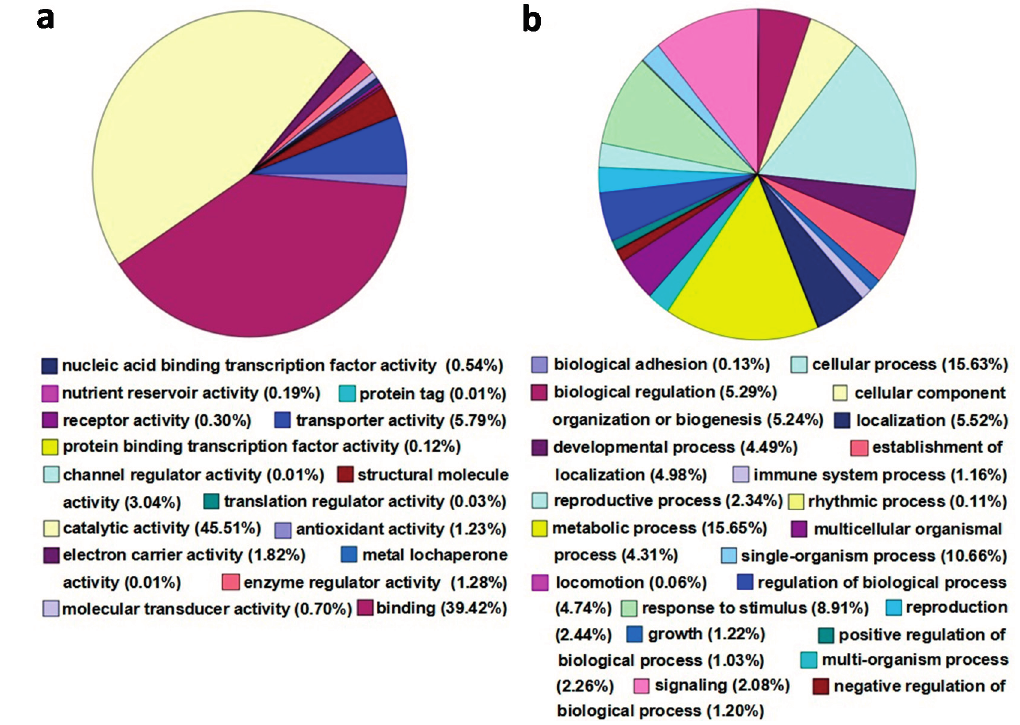
Figure 3. Gene Ontology (GO) annotation of the whole identified proteins. ( a , b ) represented the classification of molecular function and biological process of the identified proteins,